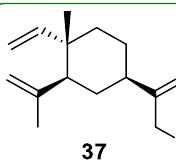
Figure 9. Chemical structures of β -elemene aminated derivatives 38a – g .